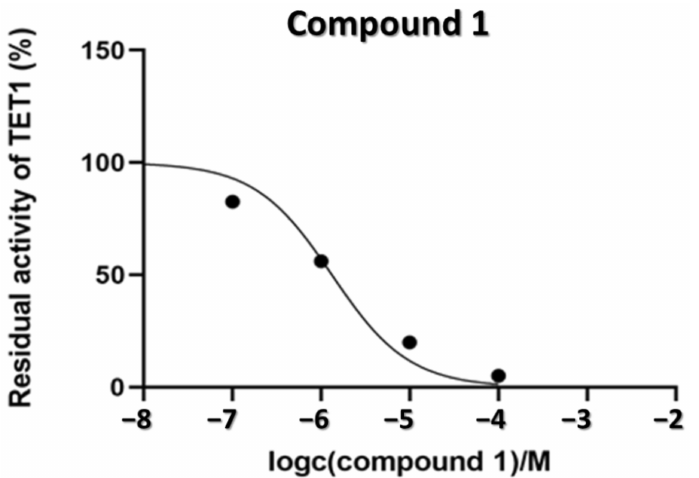
Figure 4. Dose-response curve of residual TET1 activity on the concentration of compound 1 , IC 50 = 1.37 µ M (see Section